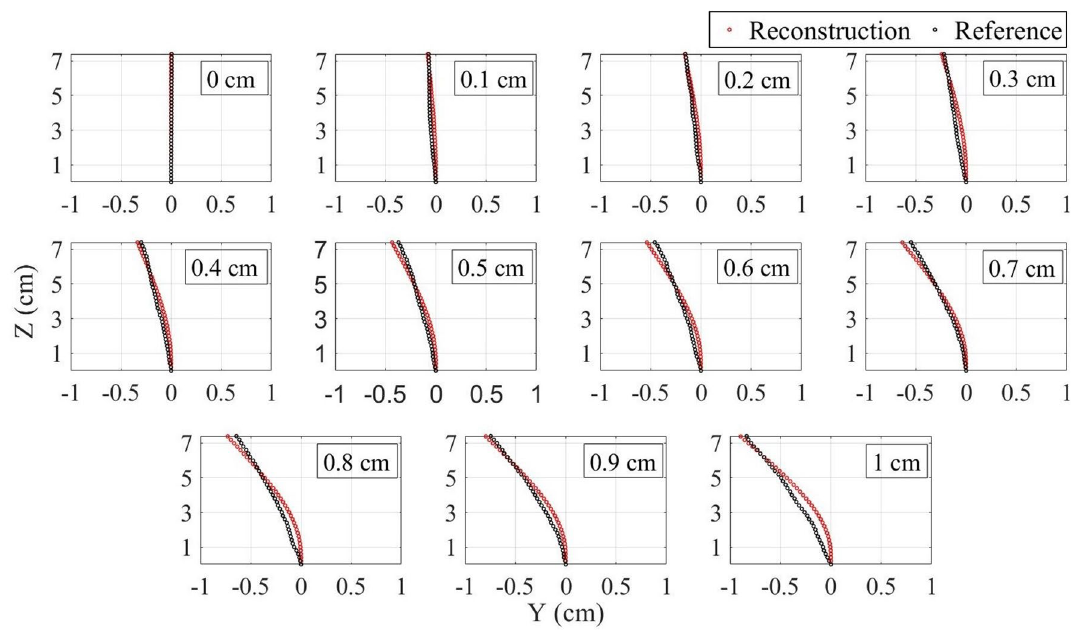
Figure 3. Comparison of the reconstructed shape (red) with the reference (black) after the application of the correction coefficients during the needle bending to the lower